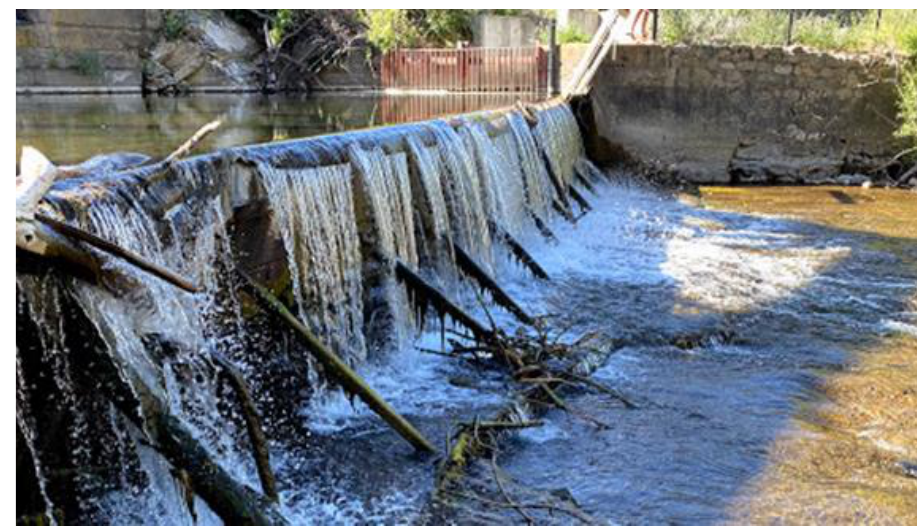
Figure 1. Low-head dam at Provo River by Provo Canyon (Photo by Salvador Vinay).